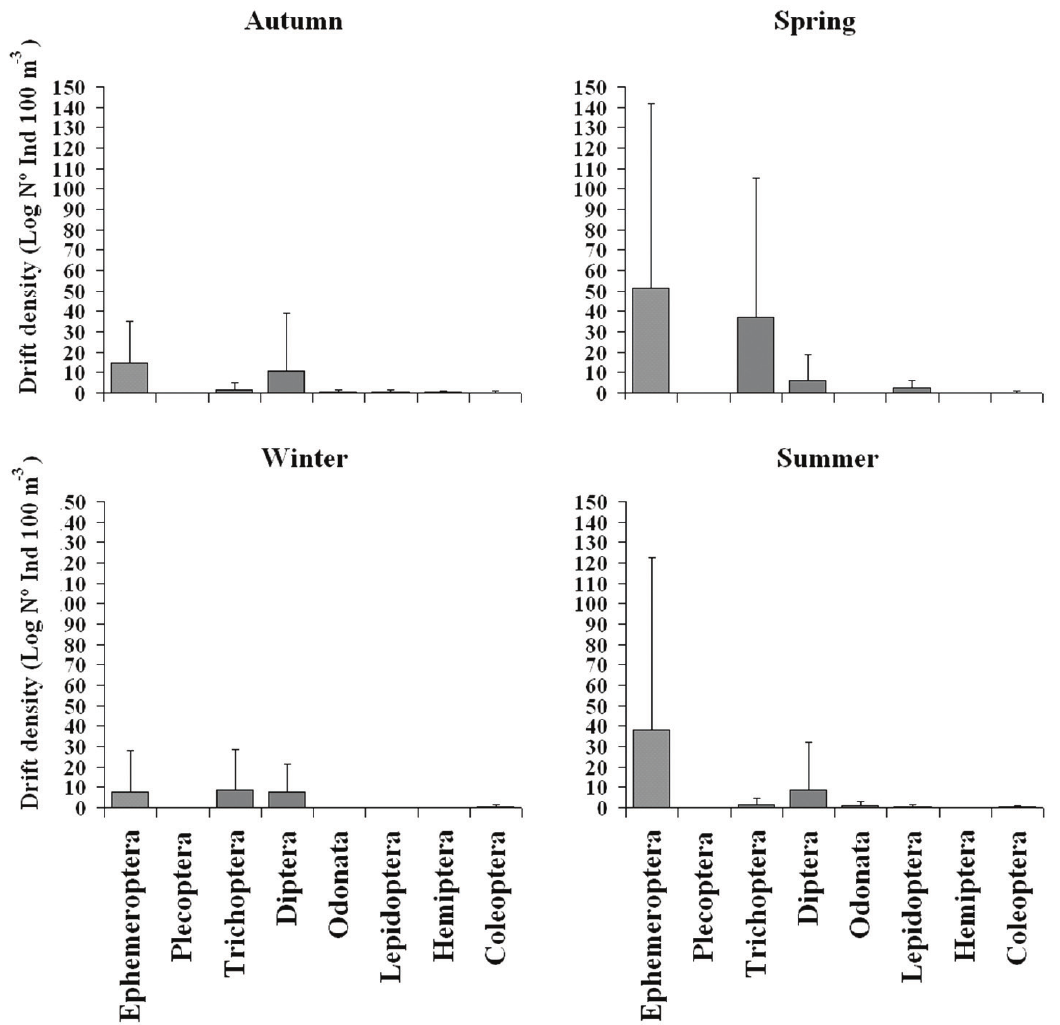
Figure 3. Drift density (Log Nº Ind 100 m –3 ) of the Insecta orders during the different seasons, in Achiras stream. Mean values and standard deviation are